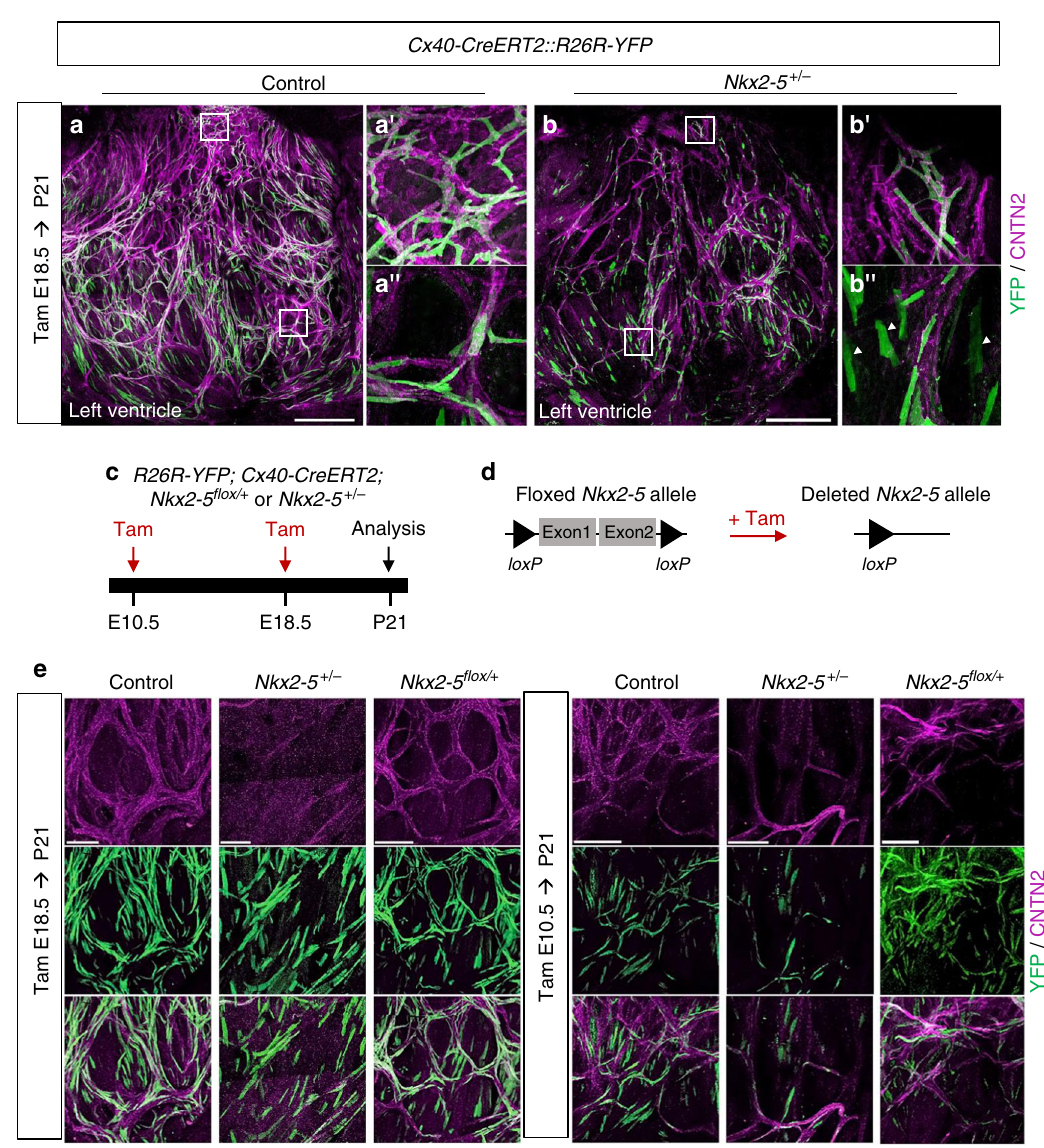
Fig. 6 Cx40 + lineage tracing identi fi es that a maximal level of Nkx2-5 is required during embryonic stages for proper Purkinje network development. a and b Genetic tracing of Cx40 + cells labeled at E18.5 by Tam injection. Confocal images of whole-mount CNTN2-immunostaining of Cx40-CreERT2::R26R-YFP opened-left ventricle at P21. a ″ and b ″ , Immunostaining for YFP and CNTN2 on control, or Nkx2-5 + / − mice shows E18.5 Cx40 + -derived cells that participate to the PF network. Scale bars = 1mm; a ’ and b ’ are high magni fi cations of left bundle branch; a ″ and b ″ are high magni fi cations of PF. c – e Strategy to induce conditional deletion of one copy of Nkx2-5 allele ( Nkx2-5 fl ox/ + ) using Cx40-CreERT2 line as inducible Cre driver. Deletion is performed at E18.5 when Cx40 + cells are mostly PF cells or E10.5 before the massive recruitment of late progenitors. R26R-YFP reporter line is used to compare the genetic tracing of Cx40 + -derived cells within P21 control, Nkx2-5 + / − and Nkx2-5 fl ox/ + hearts ( N = 7 of each genotype for E18.5 and N = 3 for E10.5). e Confocal imaging of left PF network. Scale bars = 500 µ m; arrowheads indicate non-conductive Cx40 + -derived